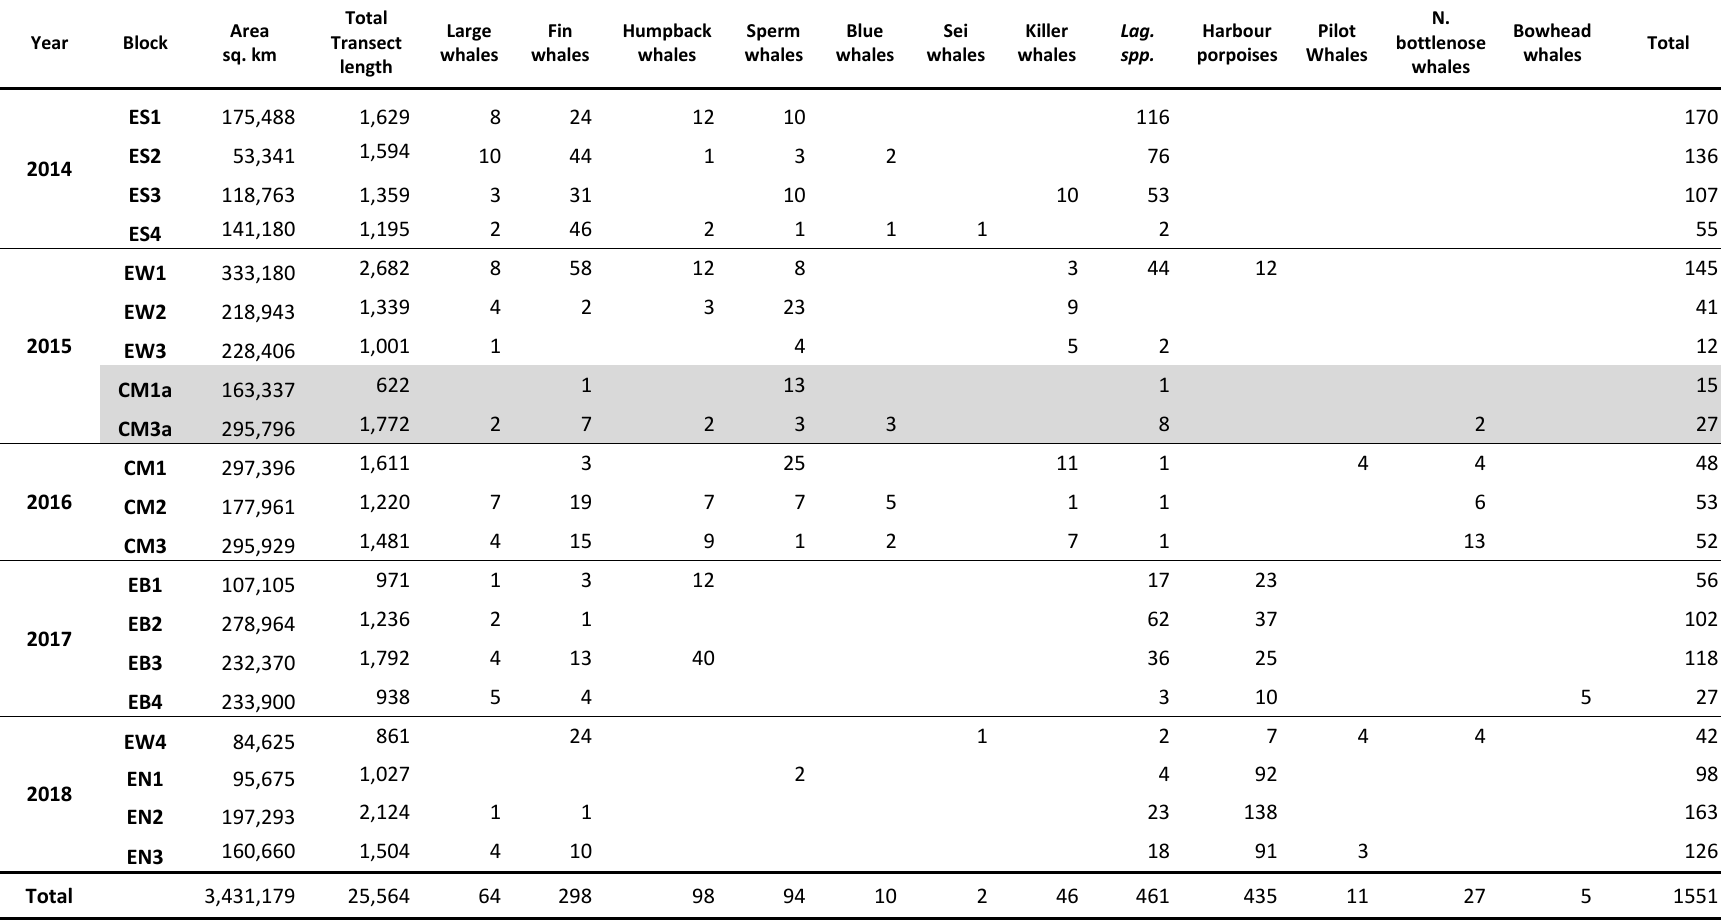
Table 2. Summary of effort and sightings for each species, survey block, and year. The NASS extension survey blocks are shaded grey and excluded from the summed